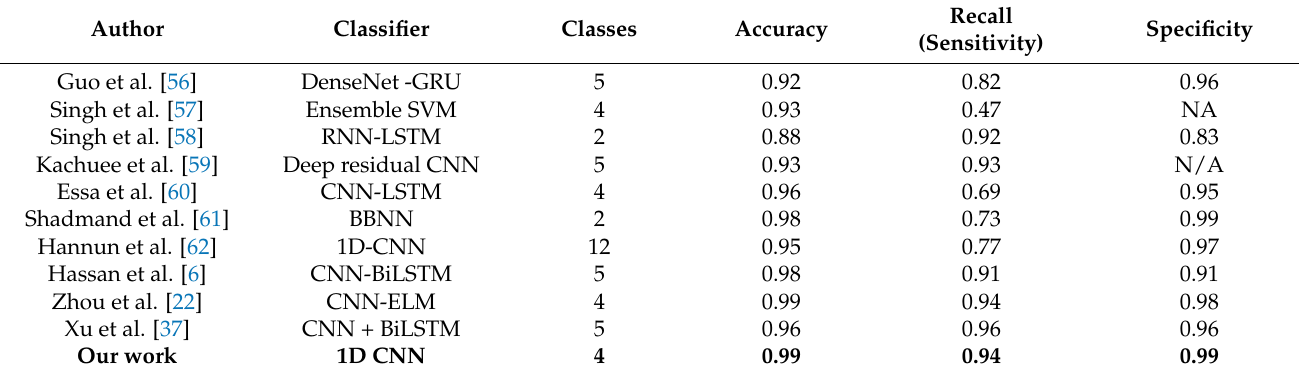
Table 4. Existing work for arrhythmia classification from ECG